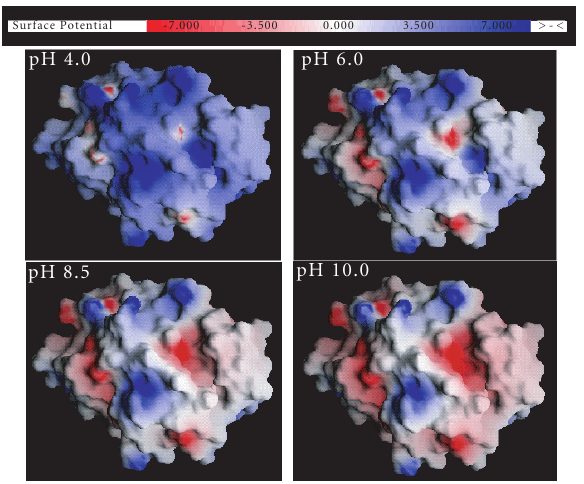
Figure 6: Visualization of the electrostatic potential on the surface at 4 different pH values of cutinase. Mapping the calculated par- tial charges to the surface of cutinase. Each titratable residue was predicted by TITRA. The potential distribution on the cutinase sur- face was calculated by DelPhi and displayed by Grasp. Charge at the surface of the enzyme at pH 4 . 0 , pH 6 . 0 , pH 8 . 5 , and pH 10 . 0 .